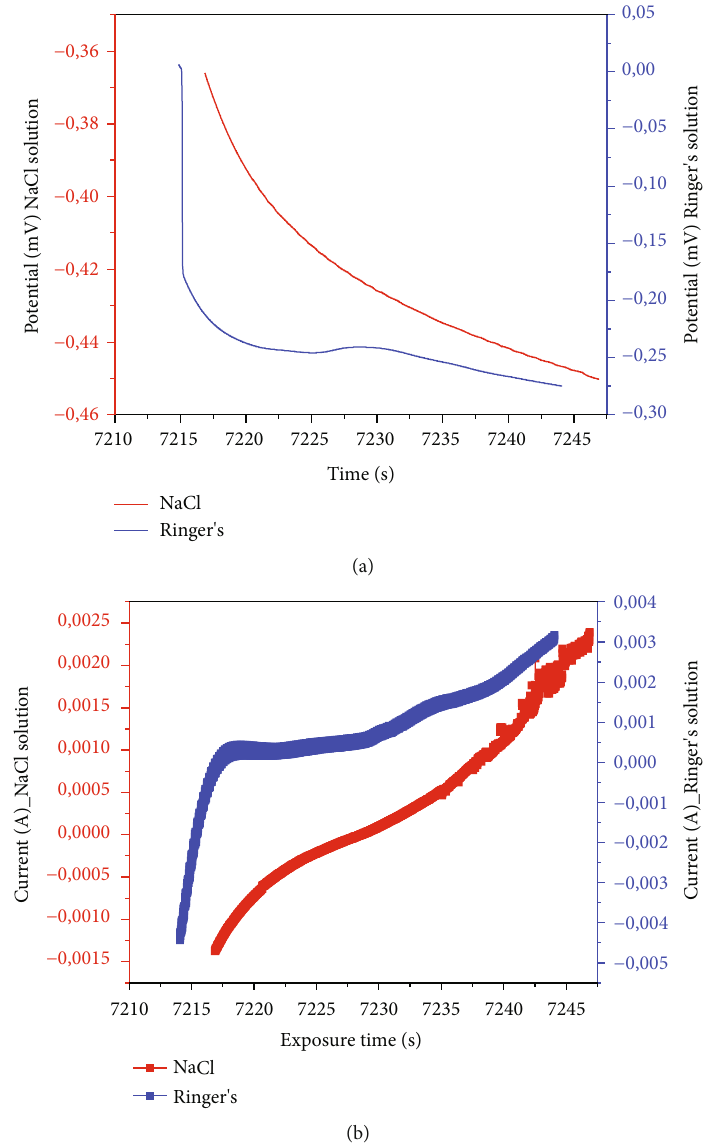
Figure 3: Evolution of OCP: (a) potential versus exposure time for NaCl and Ringer ’ s solutions and (b) Current versus exposure time for NaCl and Ringer ’ s